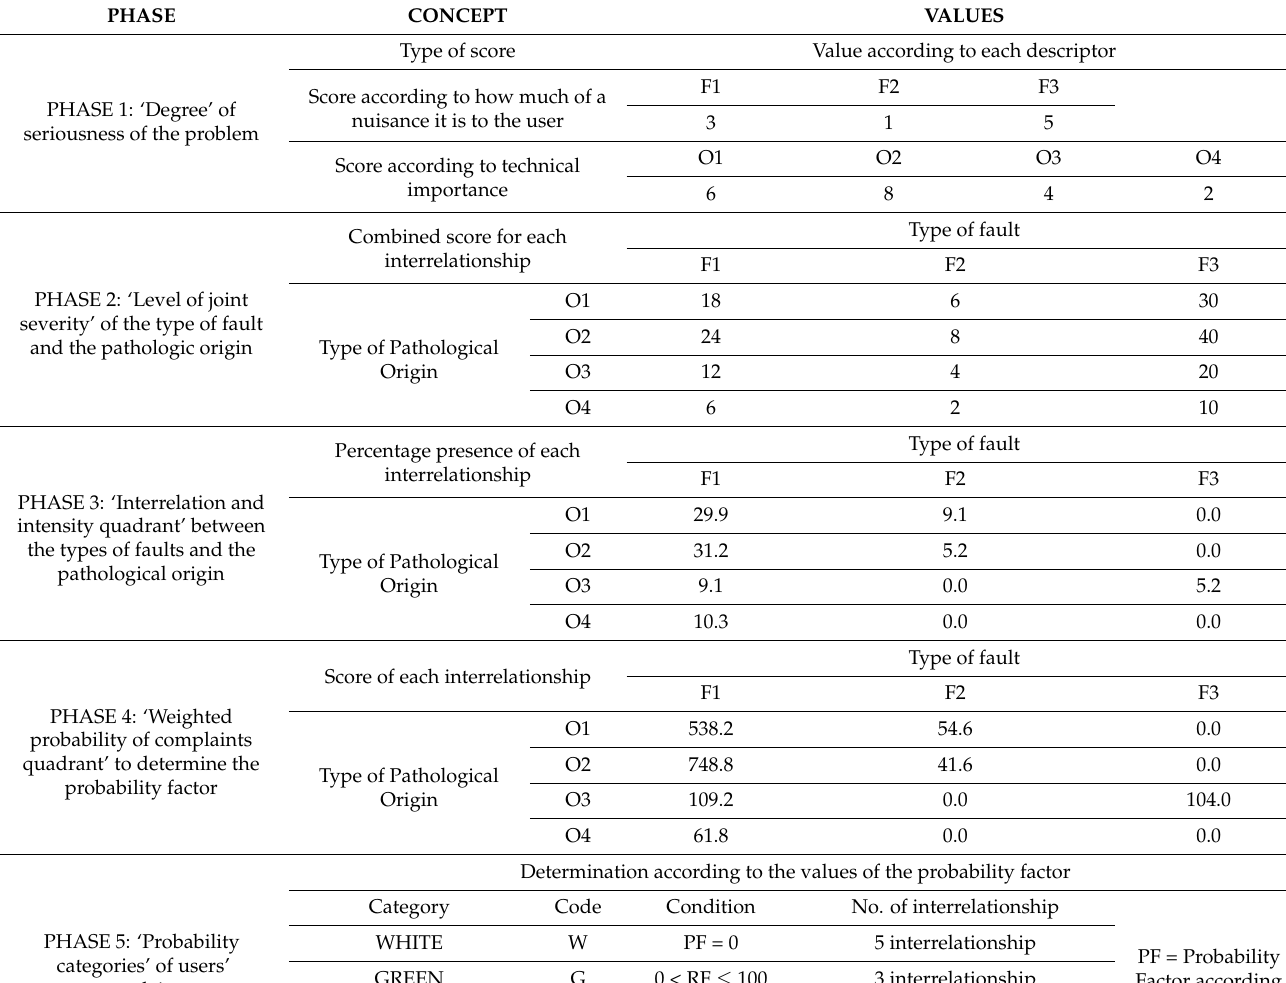
Table 5. Determination of the probability of complaints by owners of